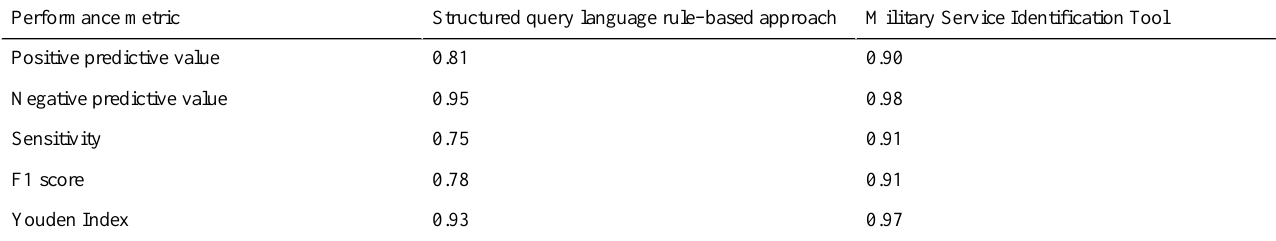
Table 6. Structured query language–based approach and Military Service Identification Tool (MSIT) performance result comparison for detecting veterans using the gold standard test dataset. The MSIT includes pre- and